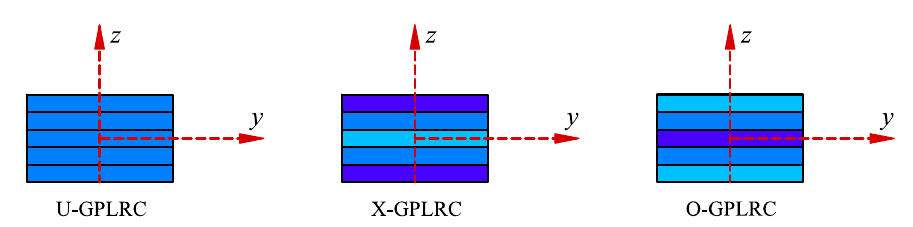
Figure 1. Graphene nanoplatelets (GPLs) distribution patterns.